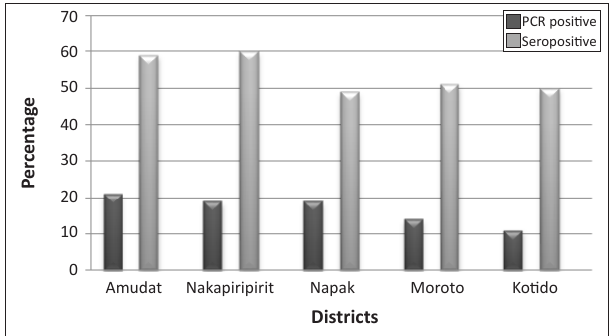
FIGURE 2: Percentage of goats found positive for BTV antibodies and RNA.